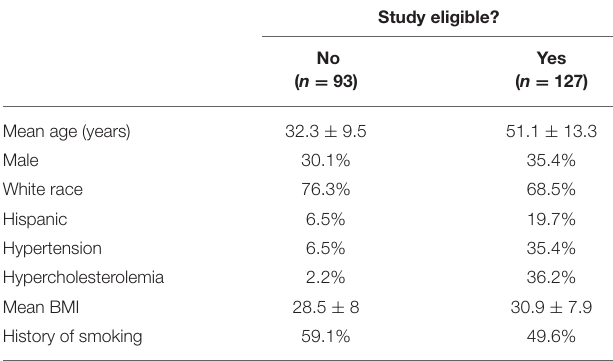
TABLE 1 | Descriptive characteristics of screened